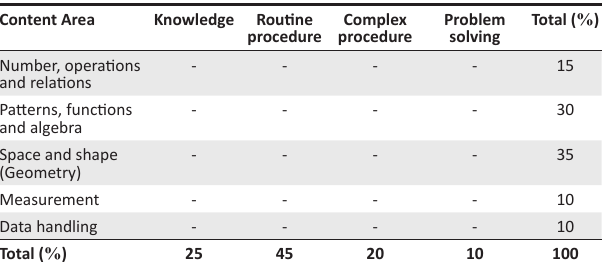
TABLE 3: Curriculum framework for test design purposes with CAPS percentages for Grade 9. Content